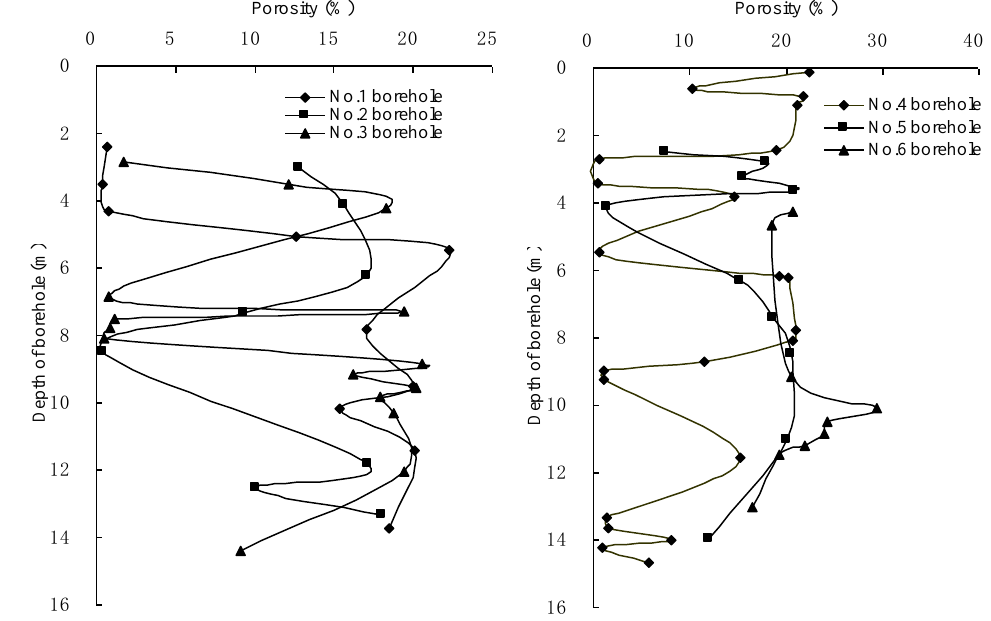
Figure 6. Relationship between porosity of RFC and depth.